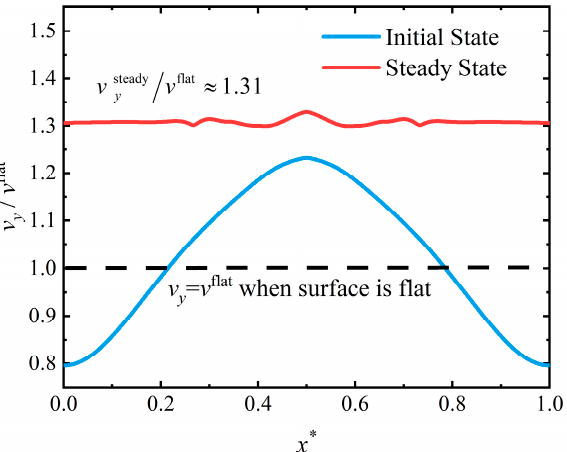
Figure 20. Distribution of the corrosion acceleration ratio v steady y / v flat along the surface under initial and steady states when A ∗ = 0.1 and σ A = 30 MPa.